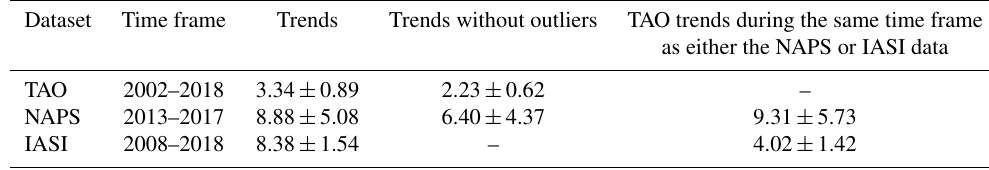
Table 2. Comparison of NH 3 trends and 2 σ confidence intervals observed in Toronto. All trends are in %/year.